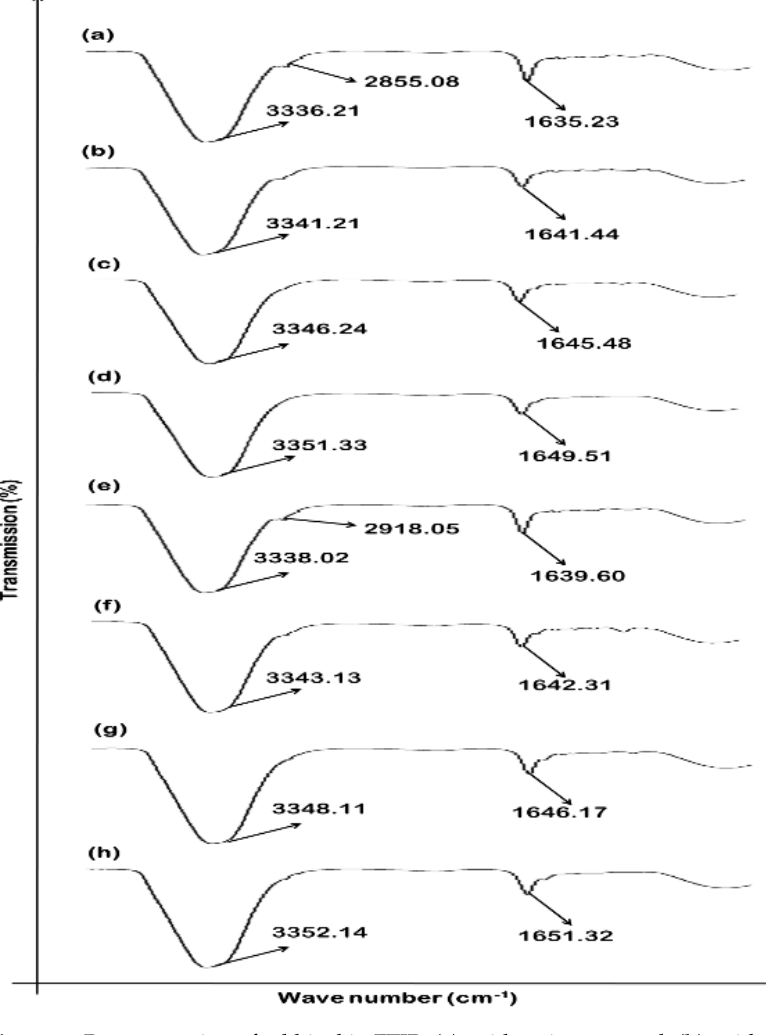
Figure 6. Representation of rabbit skin FTIR: ( a ) epidermis untreated, ( b ) epidermis treated with F1, ( c ) epidermis treated with F5, ( d ) epidermis treated with F9, ( e ) dermis untreated ( f ) dermis treated with F1, ( g ) dermis treated with F5, and ( h) dermis treated with F9. Data are expressed as mean ± SD; n = 3.